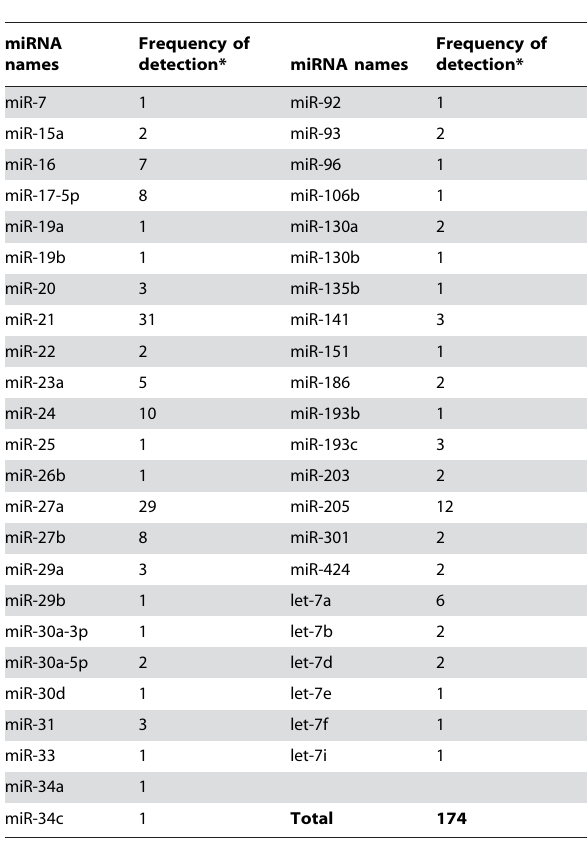
Table 1. miRNA expression profile in HPV16-positive CaSki C- 2 cells by cDNA